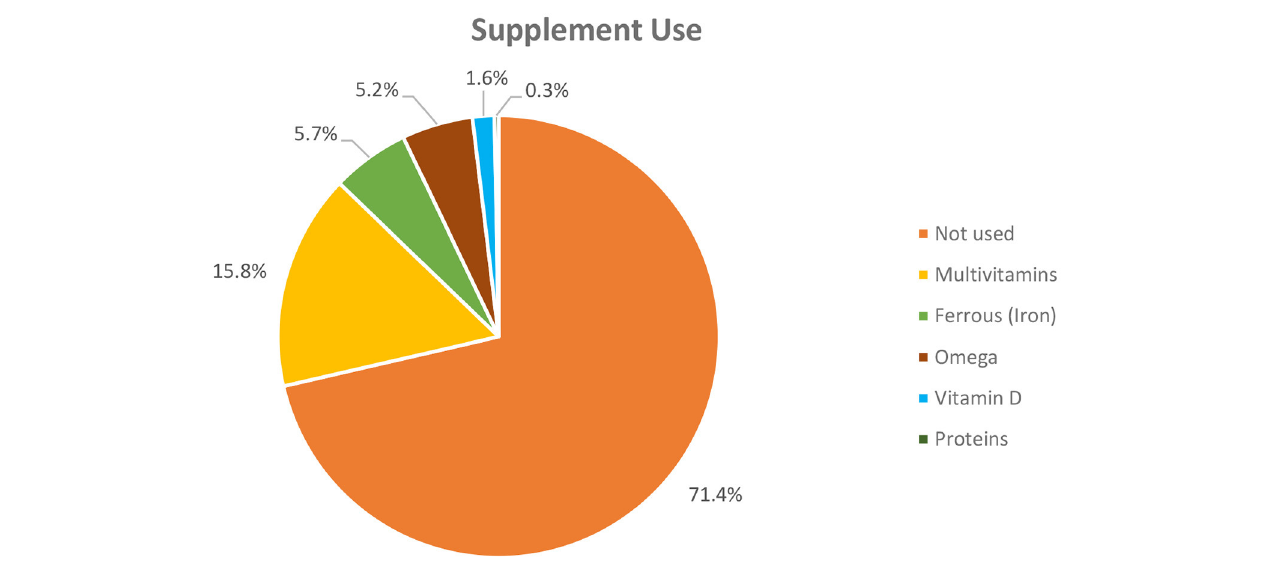
FIGURE2 Supplement use among the study participants during the pandemic.